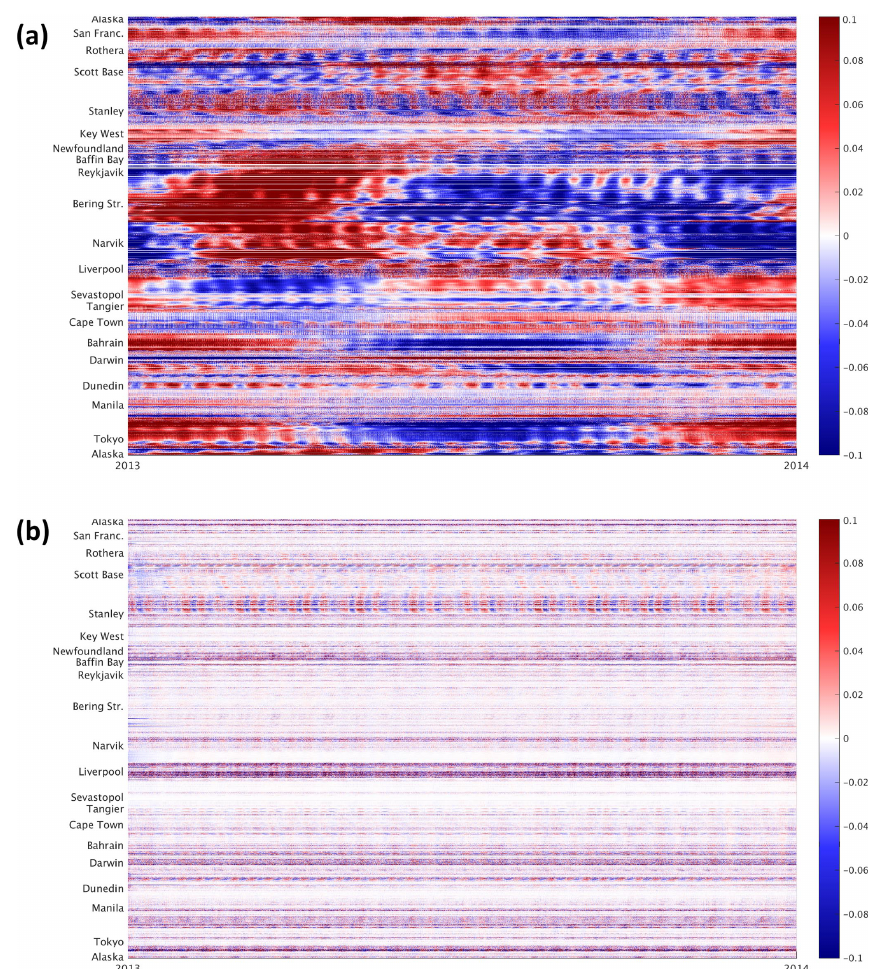
Figure 1. Time series (2013) of error (m) in 62-constituent harmonic prediction from (a) tide-and-surge e M s and (b) tide-only e M t models at estimating the tide-only model M t . The vertical axis is a continuous line around the world coastline, starting and ending at Alaska via the eastern Pacific, Antarctica, western Atlantic, Arctic, eastern Atlantic, Indian Ocean, Australasia, and western Pacific. See Appendix A for a full explanation and reference